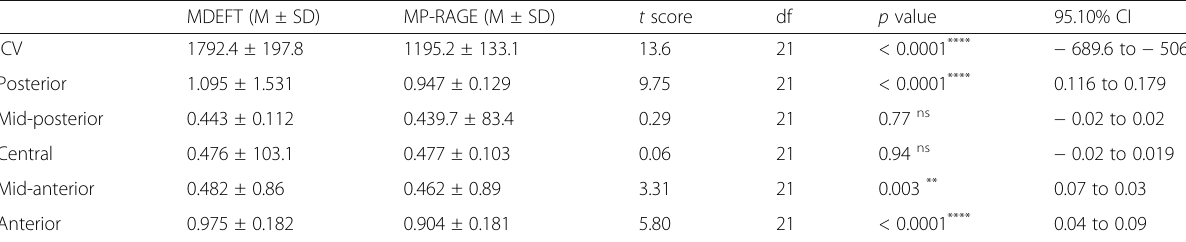
Table 3 Mean and standard deviation (SD) of intracranial volume (ICV) and volumetric measurements of CC regions versus pulse sequences (MDEFT and MP-RAGE). Volumes are in mL, ns , not